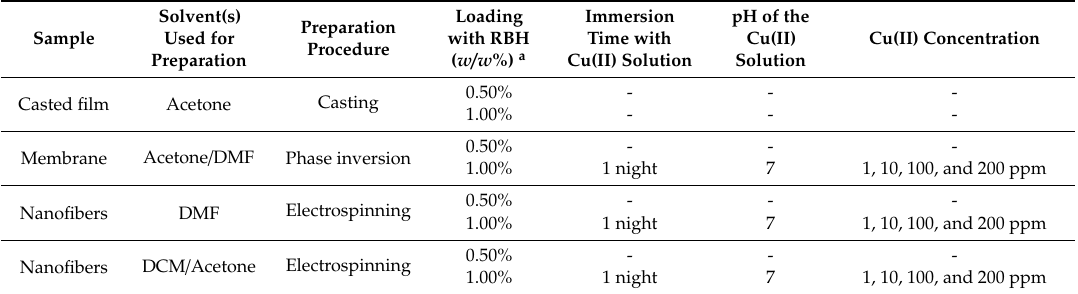
Table 1. Summary of the sample preparation procedures, dye loading, and Cu(II)